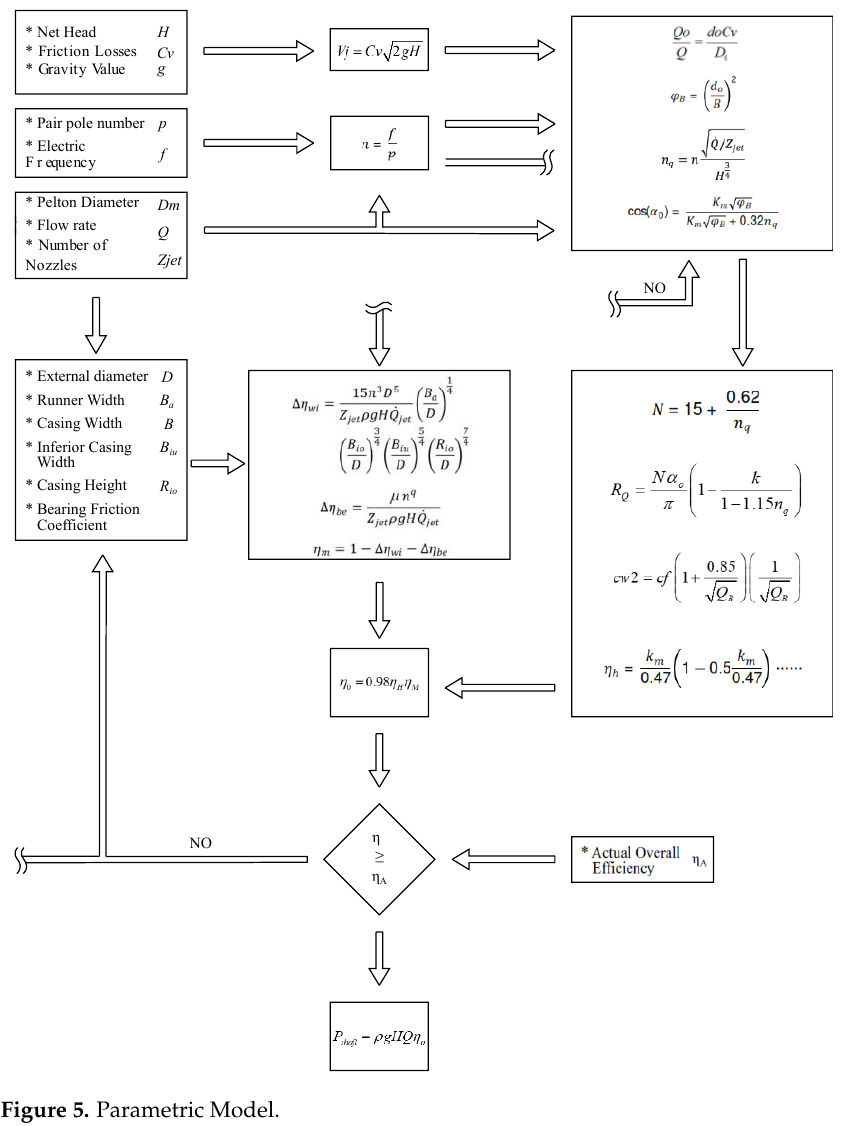
Figure 5. Parametric Model.